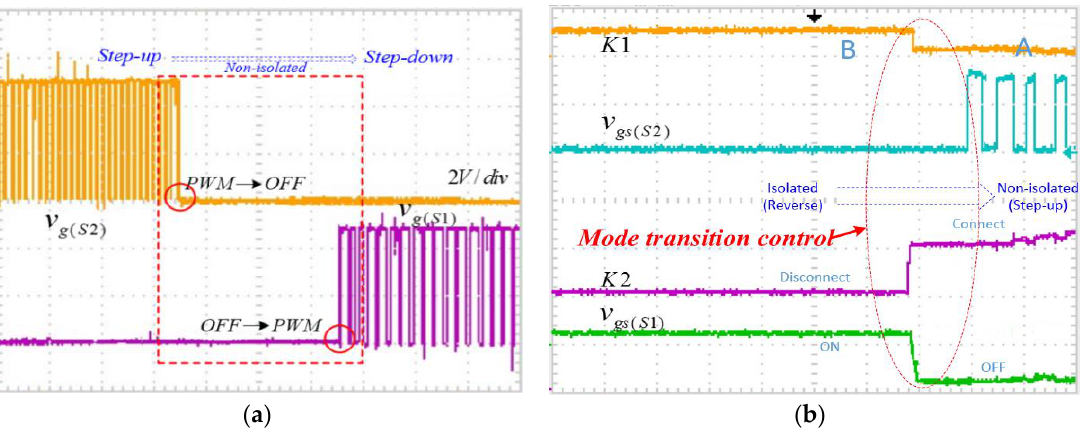
Figure 15. Experimental results for the non-isolated and mode switch: ( a ) step-up mode to step-down mode; and ( b ) mode switch.